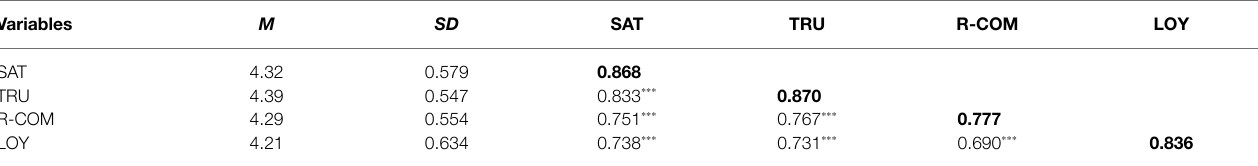
TABLE 3 | Summary table of descriptive statistics and correlation analysis.